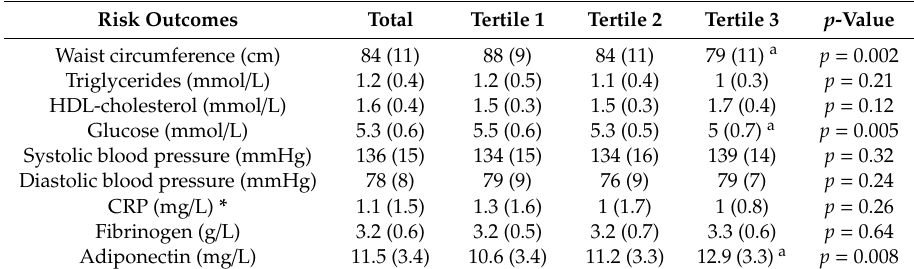
Table 2. Inflammatory and metabolic biomarkers in the study sample and across tertiles of